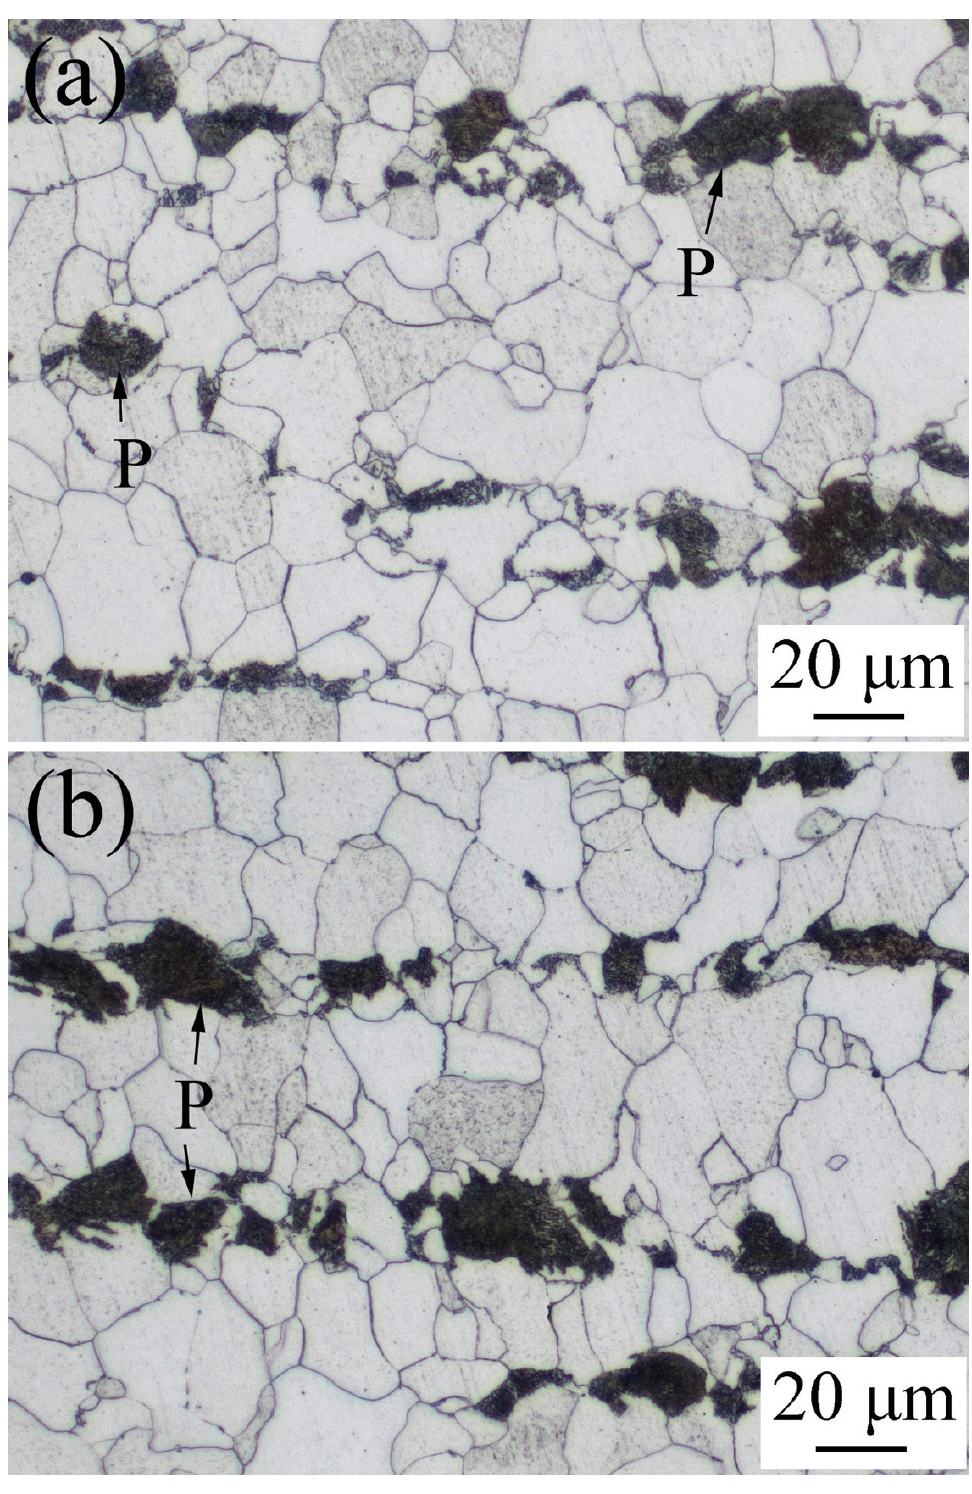
Figure 1. Microstructures of heat-treated steels: ( a ) N1-HT, ( b ) N2-HT.